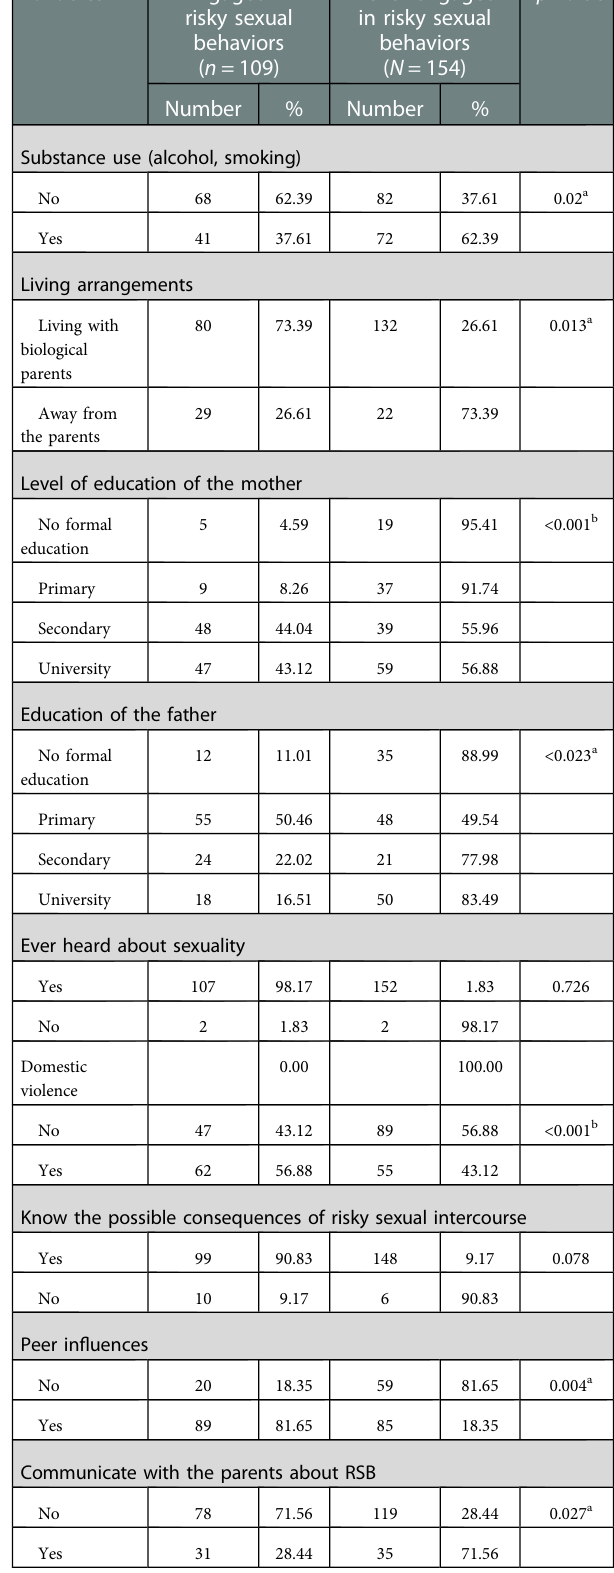
TABLE 2 Proportion of risky behavior practices by demographic characteristics and predictors associated with risky sexual intercourse among